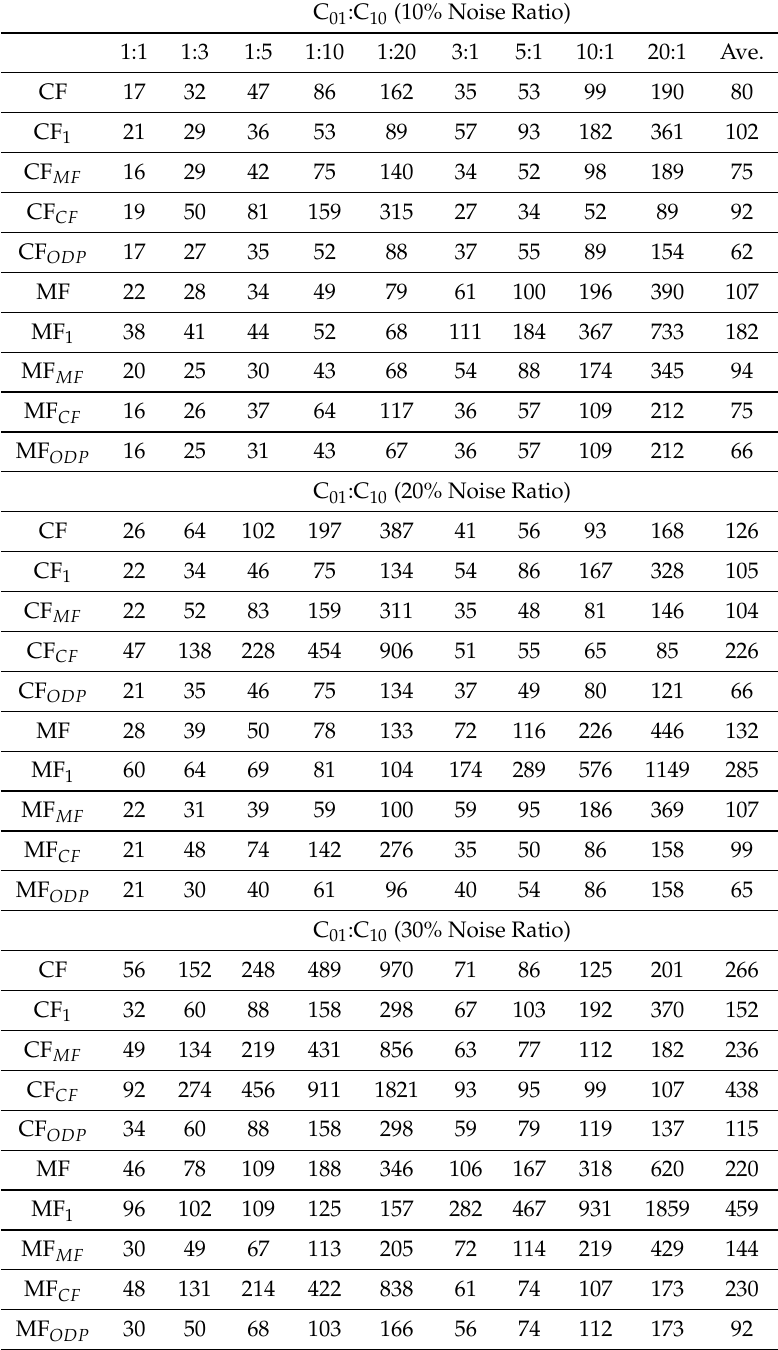
Table 10. Cost comparisons on Wdbc in the case that the noise ratio and noise-free dataset are